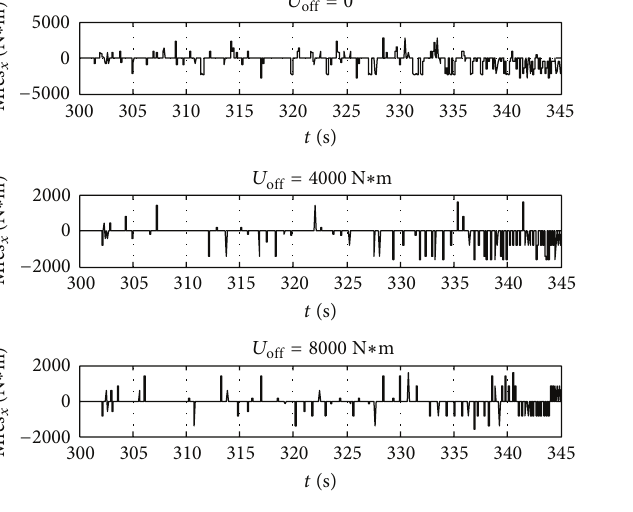
Figure 28: Simulation result of roll moment.